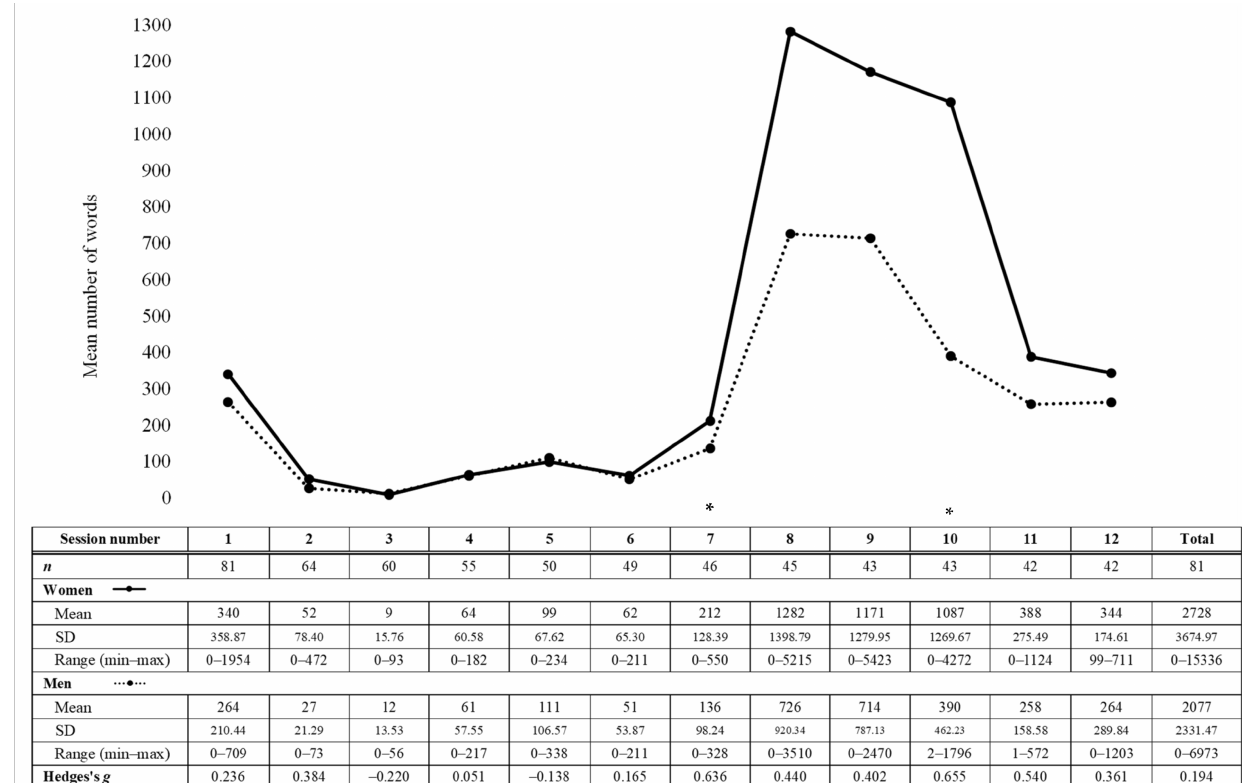
Figure 1. Means, standard deviations, range and effect sizes for number of words per session by gender. Note. Since participants presented with various levels of posttraumatic, depressive and insomnia symptoms, some of them did not use some parts of the intervention which did not apply to them. * p <